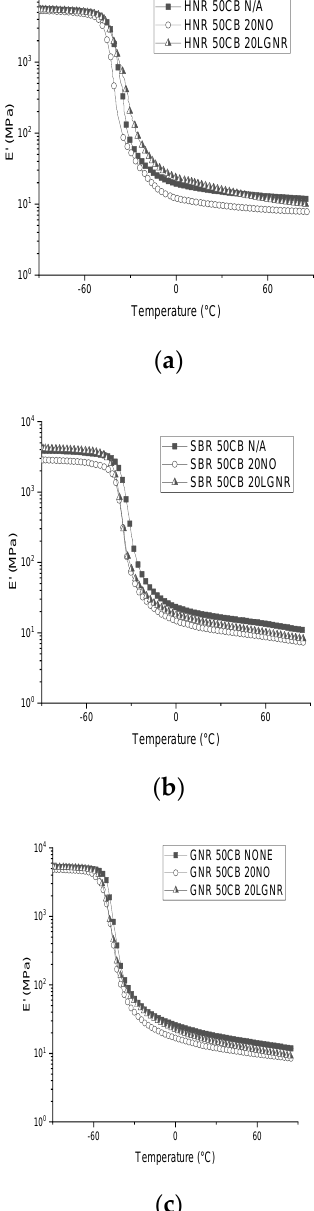
Figure 9. Storage modulus (E’) of rubber composites made with or without processing aids from - 90 °C to 90 °C: ( a ) Hevea natural rubber (HNR); ( b ) styrene butadiene rubber (SBR); ( c ) guayule natural rubber (GNR). N/A: rubber compounds without processing aids; 20 NO: rubber compounds with 20 phr naphthenic oil; 20 LGNR: rubber compounds with 20 phr liquid guayule natural rubber. The E”s of HNR and GNR composites were independent of the added processing aids in their glass states, because the rubber matrices and processing aids had similar glass transition temperatures (Figures 8 and 10a,c and Table 3). However, SBR composites made with NO had higher E”s than the other two SBR composites, due to the high plasticizing effect of NO (Figure 10b). Although LGNR also acted as a processing aid, the additional crosslinks formed between LGNR and rubber reduced the mobility of SBR molecules. E” peaks indicate the glass transition zone of rubber composites where rubber composites transfer from glass to a rubbery state with increasing temperature. In the rubbery state, the E”s of LGNR rubber composites were higher than those of NO, but were similar to the rubber composites without